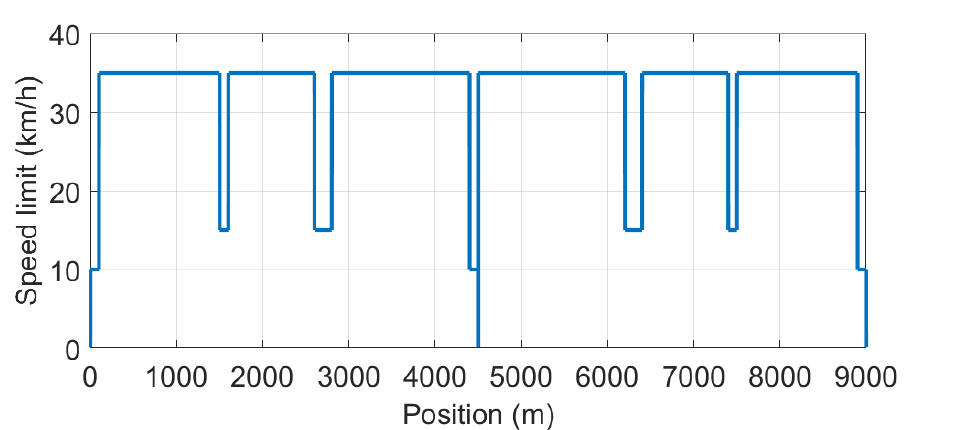
Figure 3. Speed limits for drive cycle “short 2”. Table 1. Summary of the simulated drive cycles and the length of electric road (ERS)